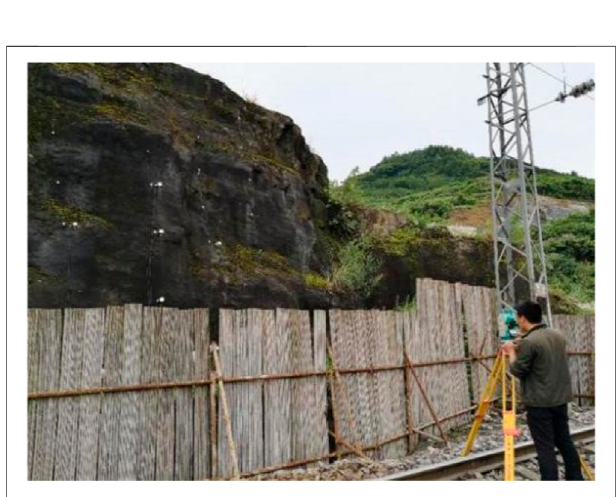
FIGURE 11 | Field measurement using a total station